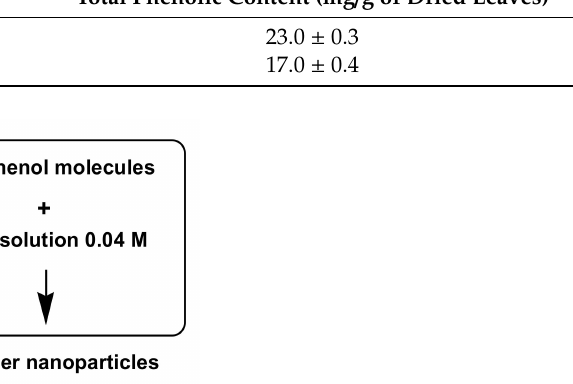
Table 2. Estimation of total phenolic content before and after the synthesis of copper nanoparticles.